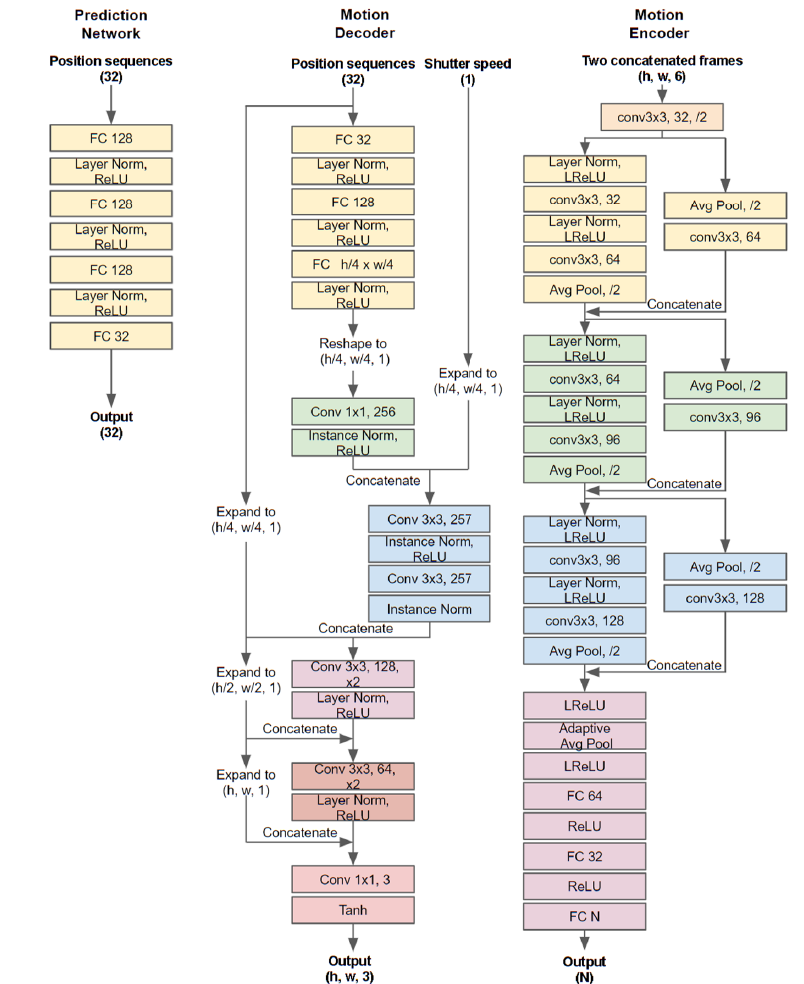
Figure 5. Detailed network architecture of the proposed